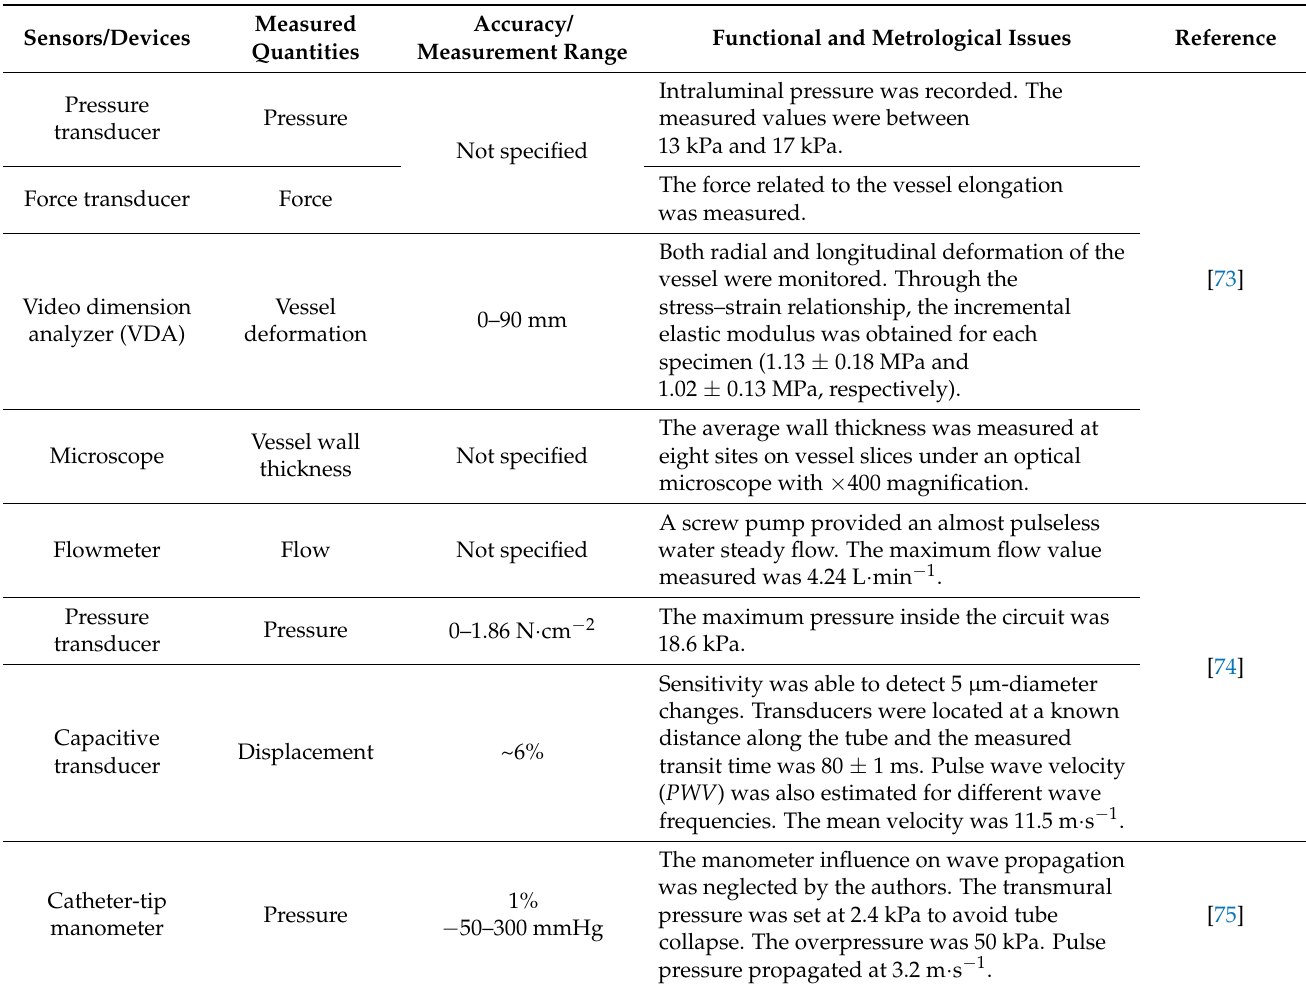
Table 6. Overview of biomechanics